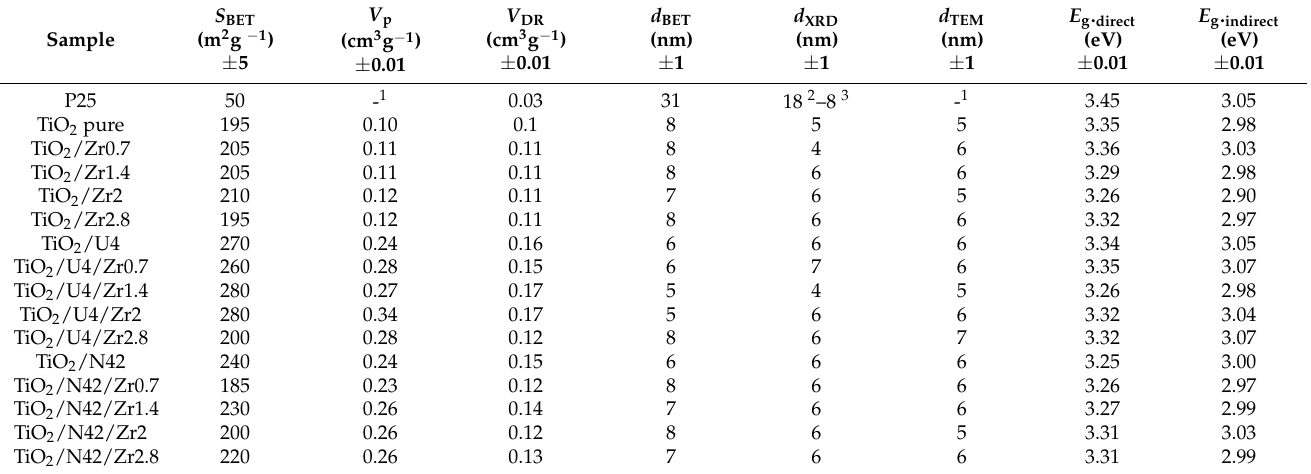
Table 2. Textural and optical properties of TiO 2 -based